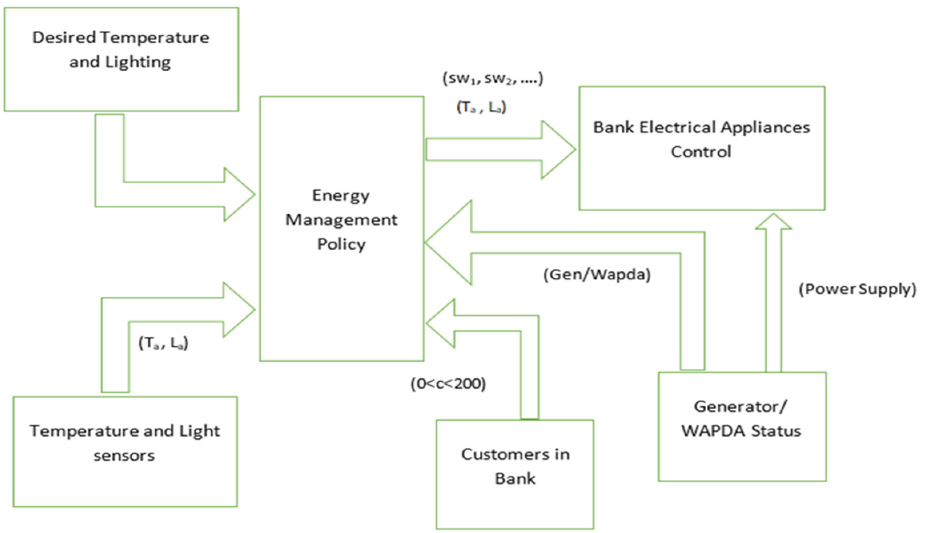
Figure 1. Block diagram.